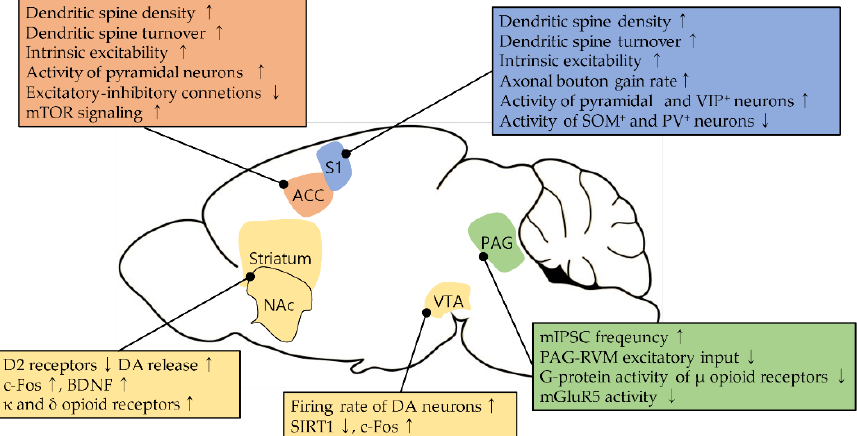
Figure 1. Neural plasticity in four brain areas during neuropathic pain. Arrows up ( ↑ ) and down ( ↓ ) indicate ‘increase’ and ‘decrease’,